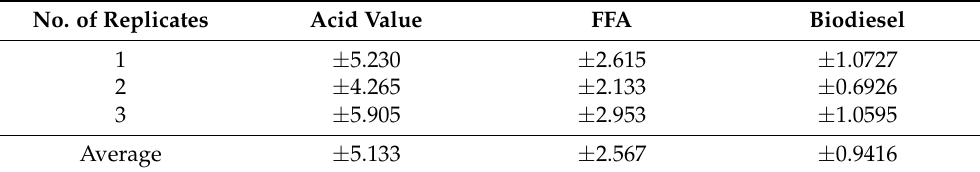
Table 1. FFA content for UCO.